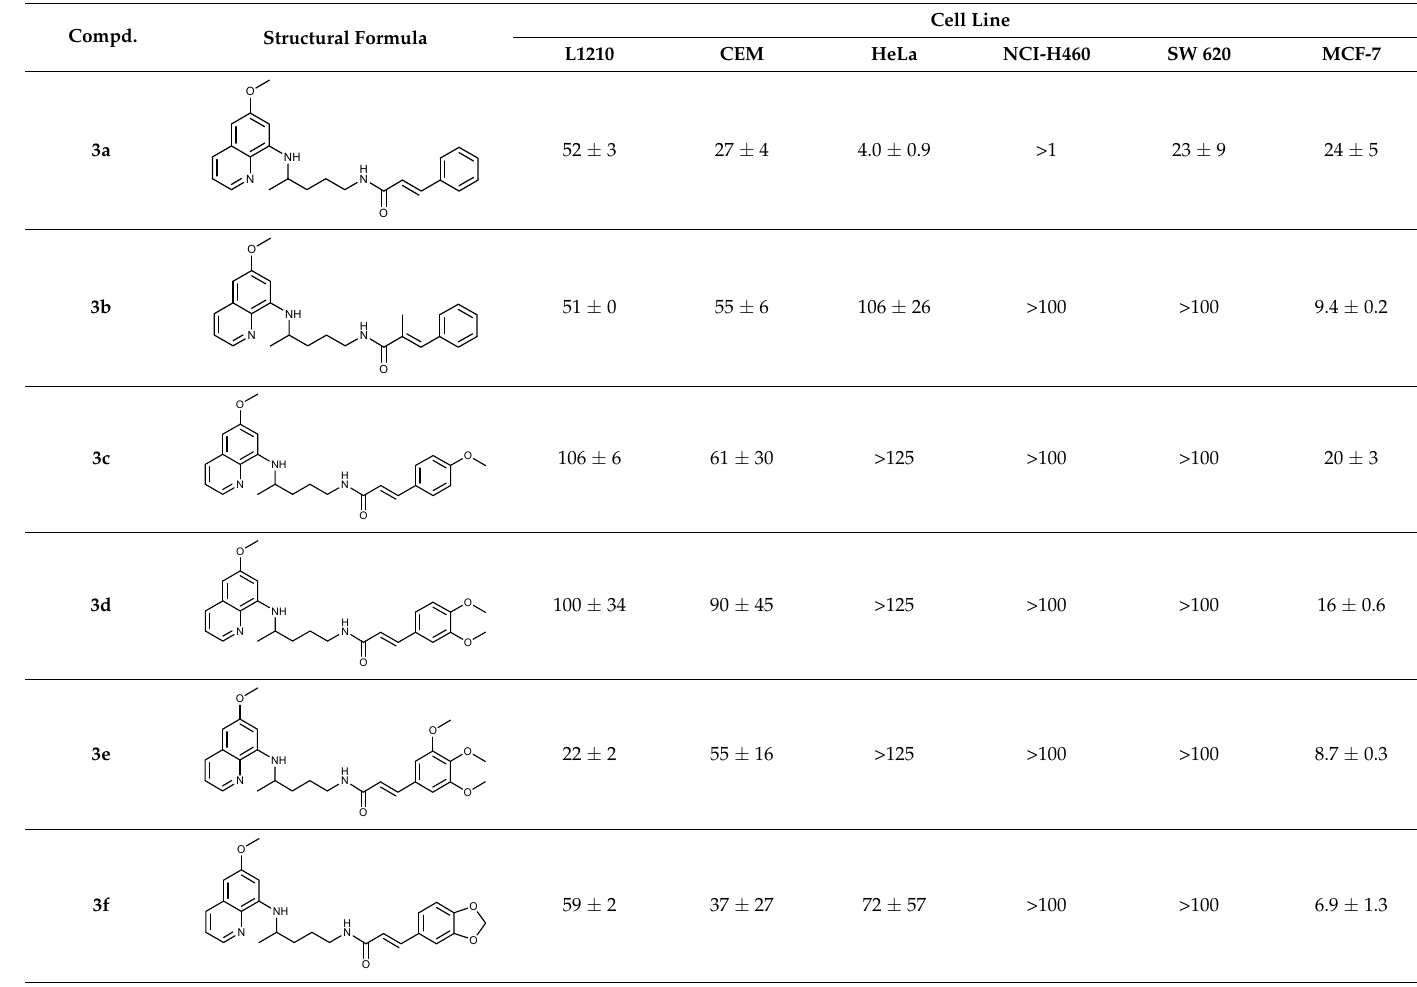
Table 2. Growth inhibition of tumor cell lines in vitro: IC 50 ( µ M) a .